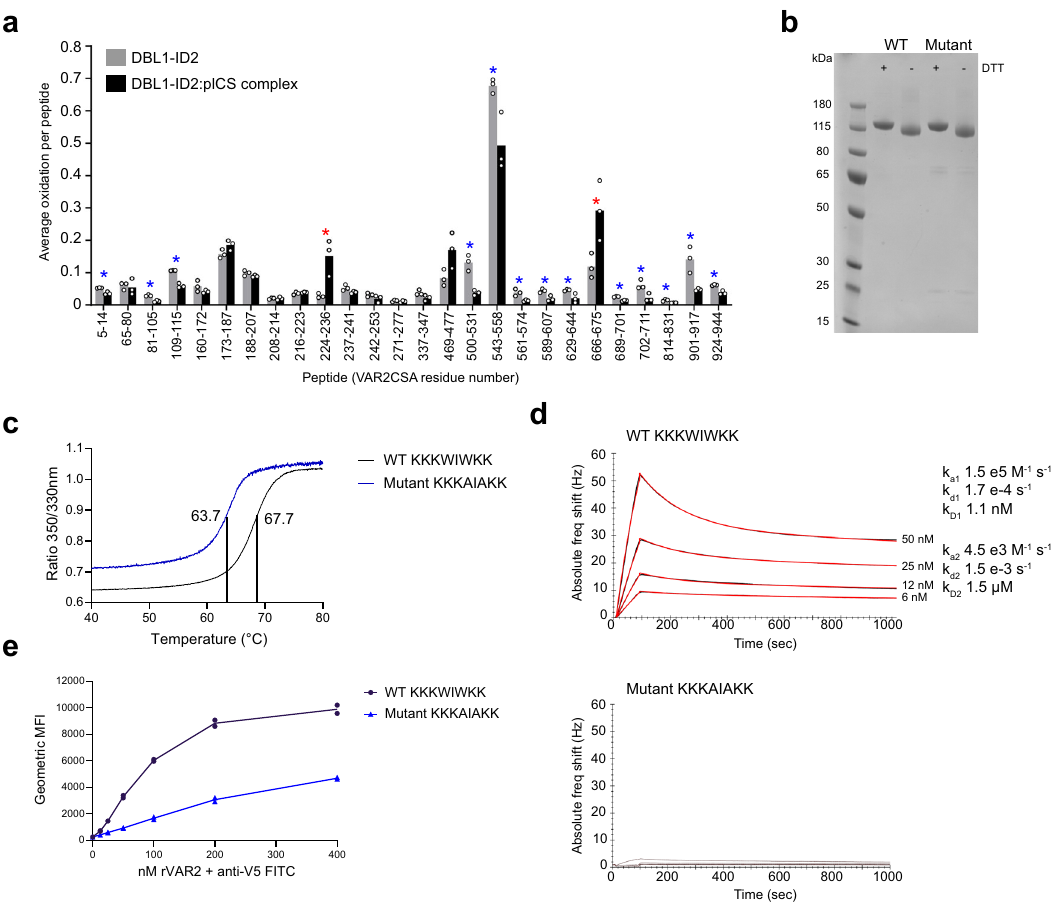
Fig. 3 Hydroxyl radical protein foot printing and CS binding analysis of DBL1-ID2 mutant. a FPOP analysis of placental CS binding to wild-type DBL1-ID2. 13 chymotryptic peptides in VAR2CSA were found to exhibit signi fi cant protection from oxidation upon binding to placental CS (blue asterisks, p < 0.05, two-tailed Student ’ s t test). Two peptides (red asterisks, p < 0.05, two-tailed Student ’ s t test) exhibit signi fi cant exposure. Peptides not detected as oxidized in either condition are not shown. b SDS-PAGE non-reduced / reduced of DBL1-ID2 wild-type (KKKWIWKK) and mutant (KKKAIAKK). The gel shown is from one puri fi cation, the mutant DBL1-ID2 was puri fi ed three times and the wild-type protein more than three times. c T m determination by nanoDSF melting curves of wild-type (T m 67.7 °C) and mutant (T m 63.7 °C) DBL1-ID2. Region between 40 °C and 80 °C is shown. d QCM biosensor kinetic measurements of wild-type (top, k D1 1.1 nM) and mutant DBL1-ID2 (bottom, no binding) to decorin CSPG. e Flow cytometry binding analyses of lung cancer cell line A549 to wild-type and mutant DBL1-ID2. Source data are provided in source data fi